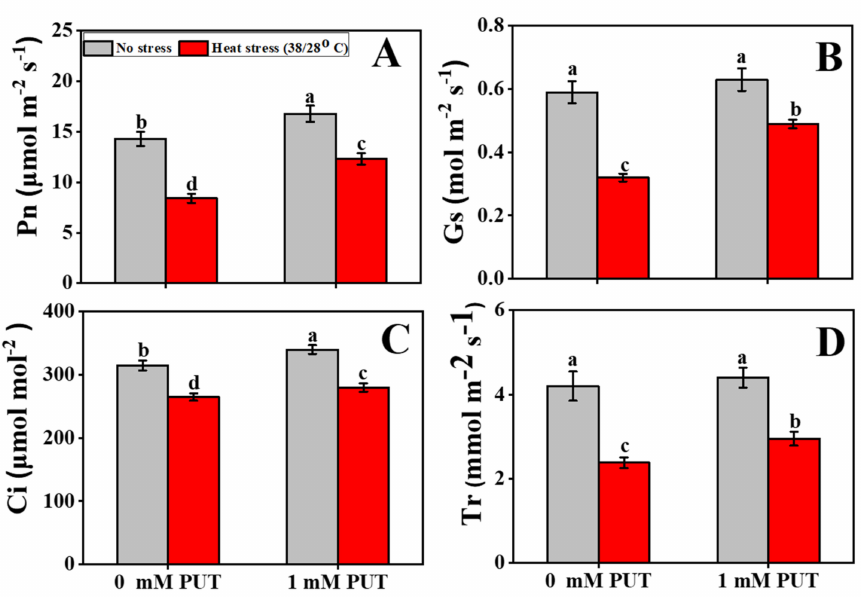
Figure 4. Interactive effects of Putrescine and high temperature on gas exchange parameter content in tomato seedlings. ( A ) Net photosynthetic rate (Pn) content, ( B ) Stomatal conductance (Gs) content, ( C ) Intercellular carbon dioxide (CO 2 ) concentration (Ci) content, and ( D ) Transpiration rate (Tr) content. The data denote the mean value ± standard error (n = 3). Different alphabetic letters represent the significant differences among the treatments at p < 0.05, according to Tukey’s